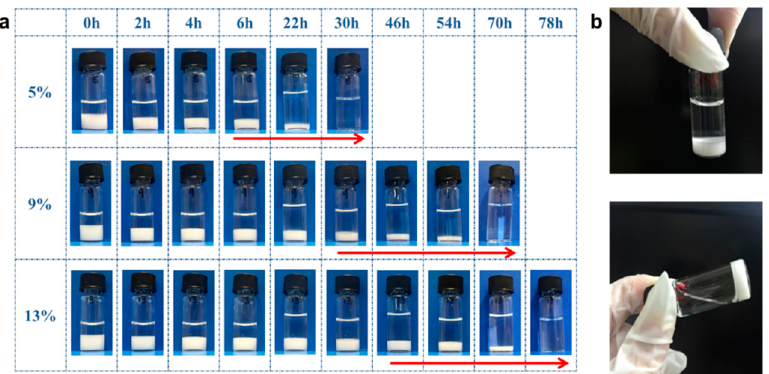
Figure 6. Images of the PGS-PEGMEMA1/ α CD hydrogel. ( a ) Images taken at various time points for 5%, 9% and 13% α CD. The hydrogels went through two phases of erosion at all α CD concentrations: Phase I where there was no visible change to the gel and Phase II where there was a gradual one- dimensional erosion from the top surface. Phase II had been marked by the arrow; (b ) Image taken at 54 h for α CD concentration of 13%. The hydrogel had started to erode but the un-eroded portion was able to maintain its integrity and remain as a gel.